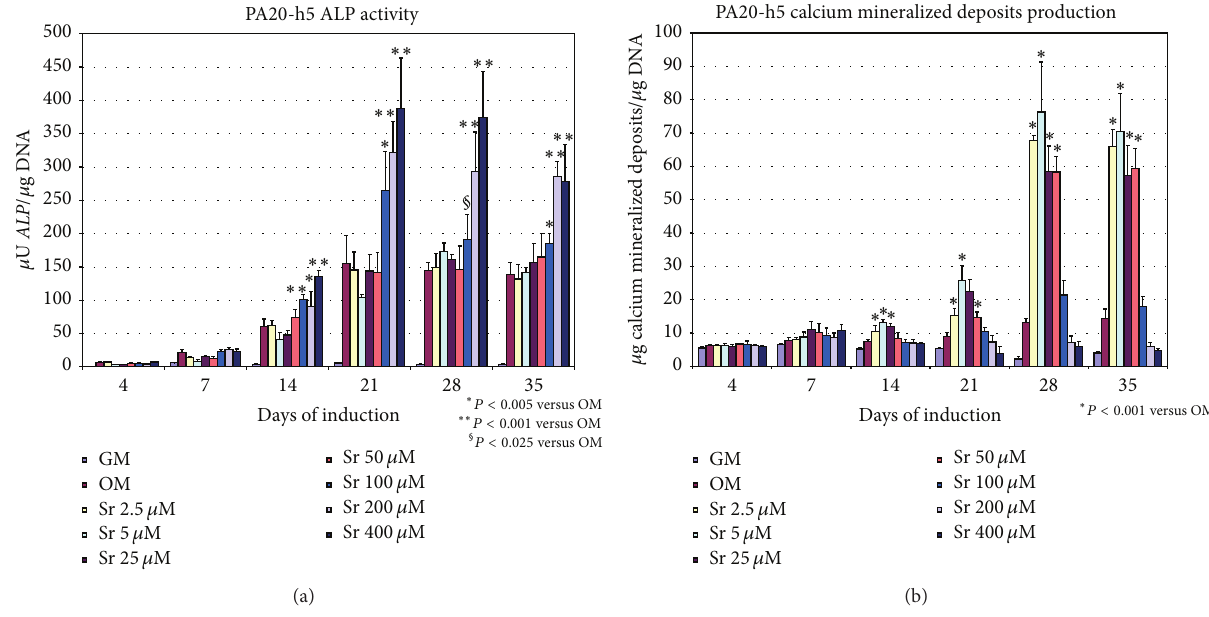
Figure 4: Quantitative analyses of ALP enzymatic activity (a) and calcium mineralized deposits (b) in PA20-h5 cultured in OM in the presence of scalar concentrations of strontium from 4 to 35 days. Experiments are carried out in triplicate and are representative of three different